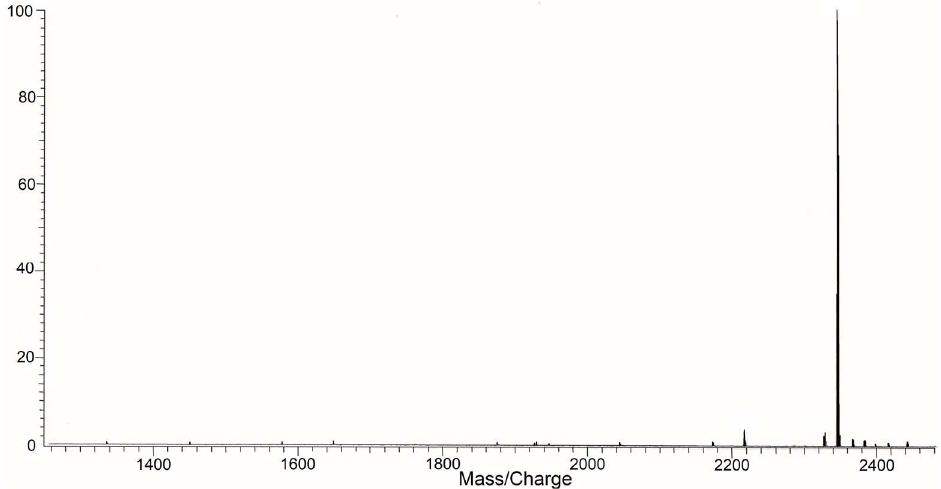
Figure 6. Mass-spectrometry data on the synthesized peptide LETI-11 (Mw = 2344.63); MS Voyager-